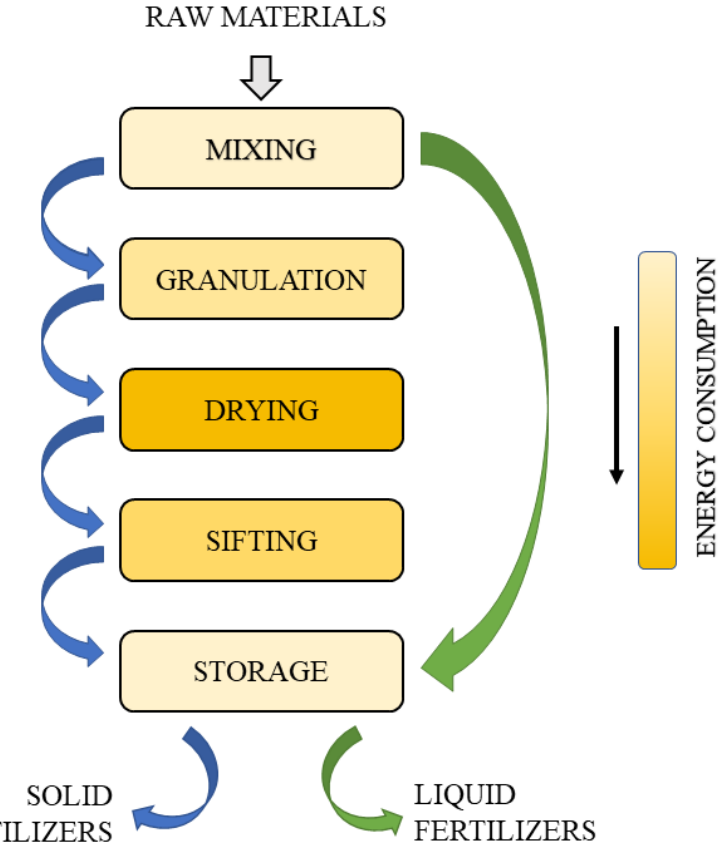
Figure 3. The production of liquid fertilizers consists of two main steps: mixing and storage. Conversely, the production of solid fertilizers consists of the following stages: mixing, granulation, drying, classification and storage. The stages marked with a darker color in the figure require more energy than those marked with a lighter color.